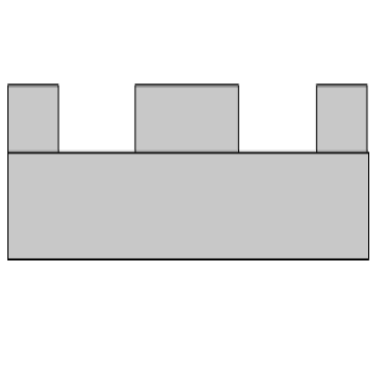
Figure 3. Comsol 2D AMR model used for the Figure 2 . Geometrical representation of simulation of magnetocaloric effect along the model. with the dimensions of various bodies